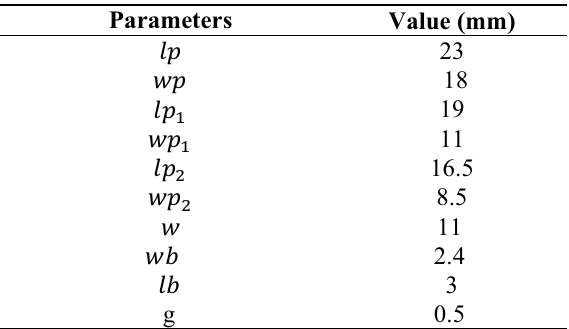
Fig.7. Phase of two output ports of the proposed dual-band patch coupler